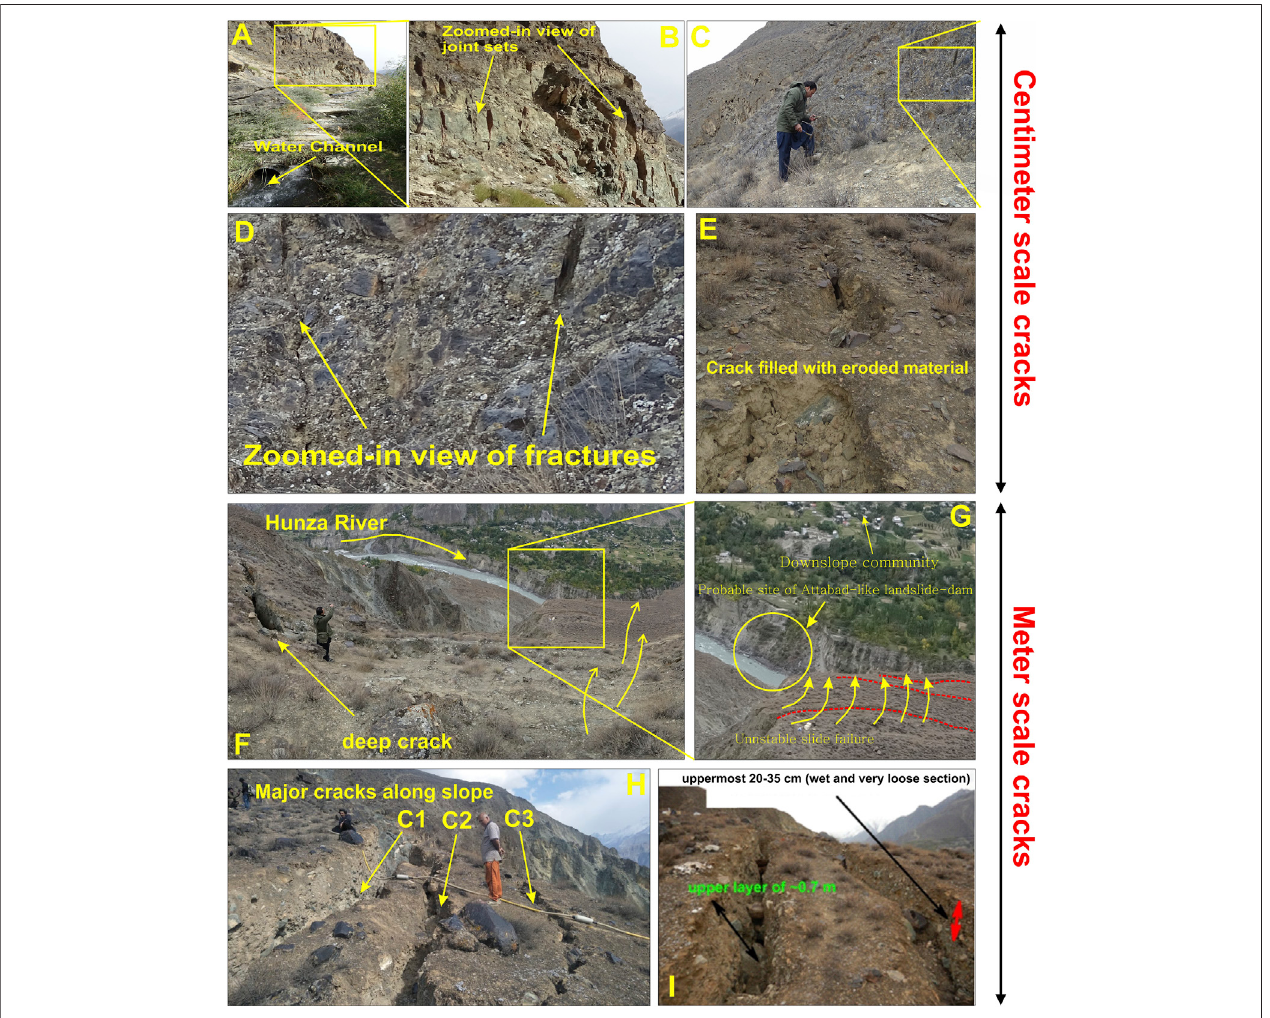
FIGURE 3 | Field observations showing centimeter- and meter-scale features covering the Mayun slope and adjacent locations towards the Hunza River. (A , B) Downslope; (C , D) upslope; (E , H) along slope; (F , G , I) slope overview towards the Hunza River with an adjacent depression and a deep crack.